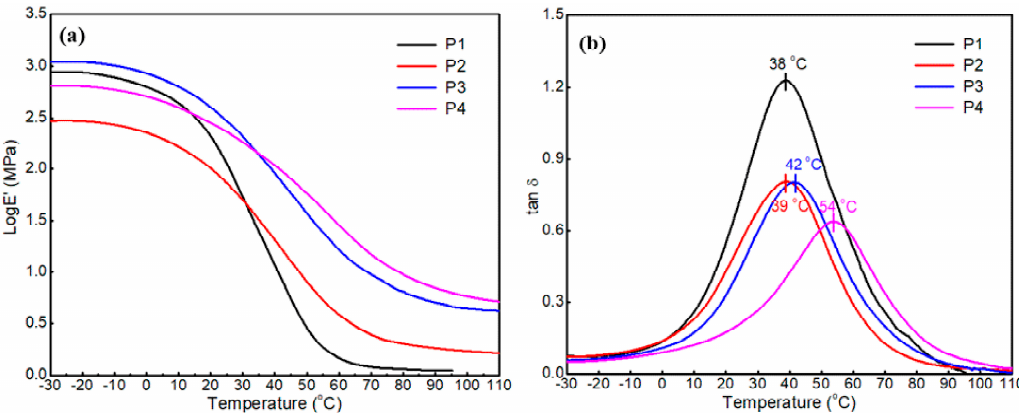
Figure 5. Dynamic mechanical analysis (DMA) of the four films: ( a ) Storage modulus and ( b ) loss factor (tan δ ) as a function of temperature of the four films. Table 4. Mechanical properties of the films.